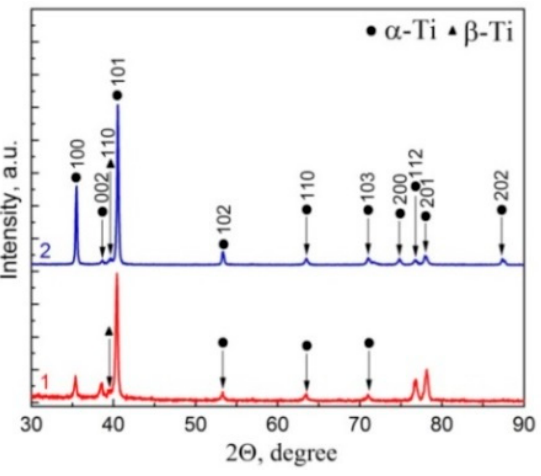
Figure 10. XRD patterns of the EBAM Ti-6Al-4V samples produced without (1) and with substrate cooling (2). XRD data were obtained from the longitudinal direction in the central part of the rectangular Ti-6Al-4V bars.